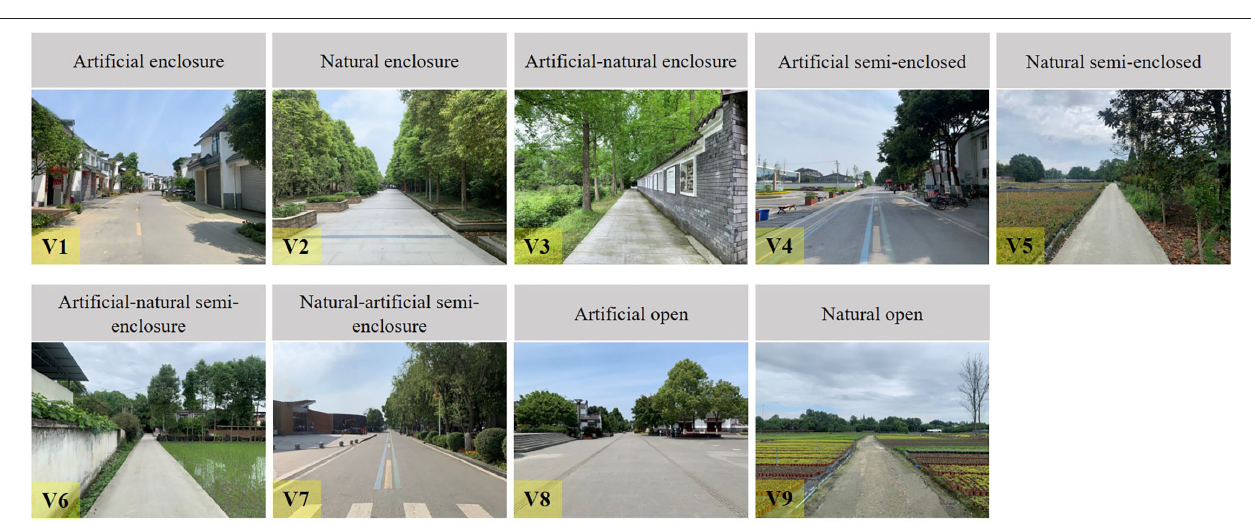
FIGURE 2 | Pictures of the different street types taken in study